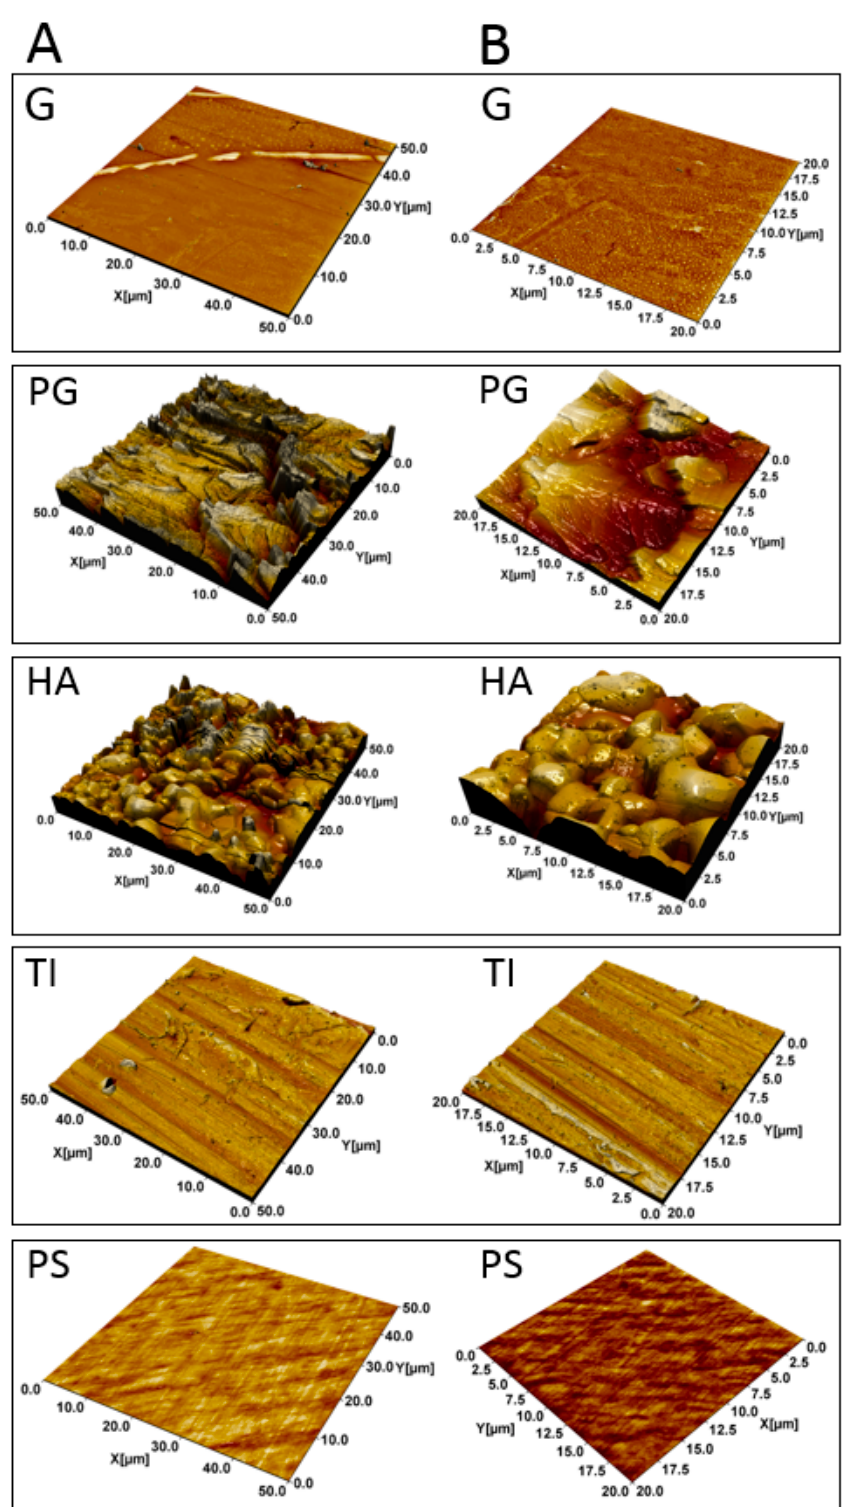
Figure 1. Atomic Force Microscopy (AFM) topographical images of the materials. Borosilicate glass (G), plexiglass (PG), hydroxyapatite (HA), titanium (TI) and polystyrene (PS) captured with the image size of 50 × 50 µ m ( A ). Zoomed images of the materials with the size of 20 × 20 µm ( B ).